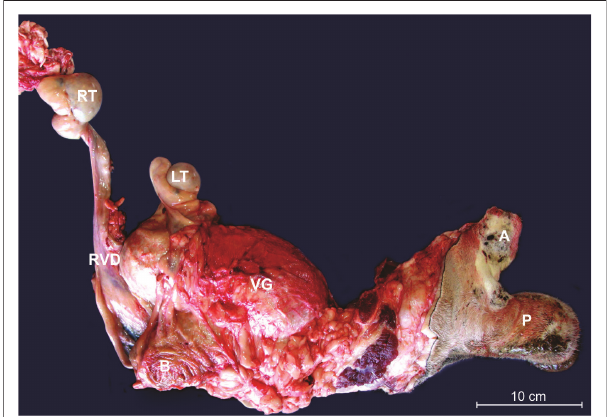
FIGURE 3: Macroscopic appearance of the abnormal genital tract ex situ with the left testis (LT) and right testis (RT), right deferent duct (right vas deferens [RVD]), distended vesicular gland (VG), penis (P), bladder (B) and anus